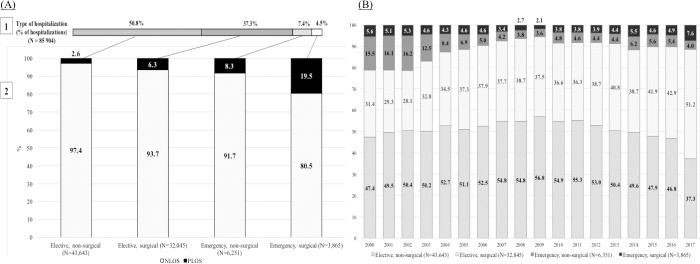
Distribution of prolonged length of stay (PLOS) events by type of hospitalization from 2000–2017.(A) Overall Distribution of PLOS events by type of hospitalization (elective or emergency and surgical and non-surgical). The frequency of PLOS was significantly higher during hospitalization events that required a surgical intervention. (B) Annual trends of the distribution of type of hospitalization. During the study period there was an important reduction in the proportion of elective and urgent surgical events of hospitalization (dark and light gray bars). Elective hospitalization events for surgical procedures increased the most during the study period.